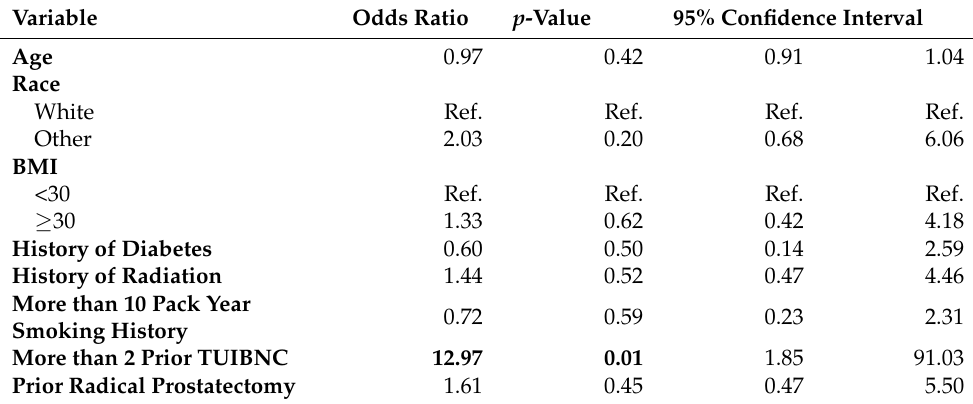
Table 2. Prediction of TUIBNC failure—multivariable logistic regression (N =